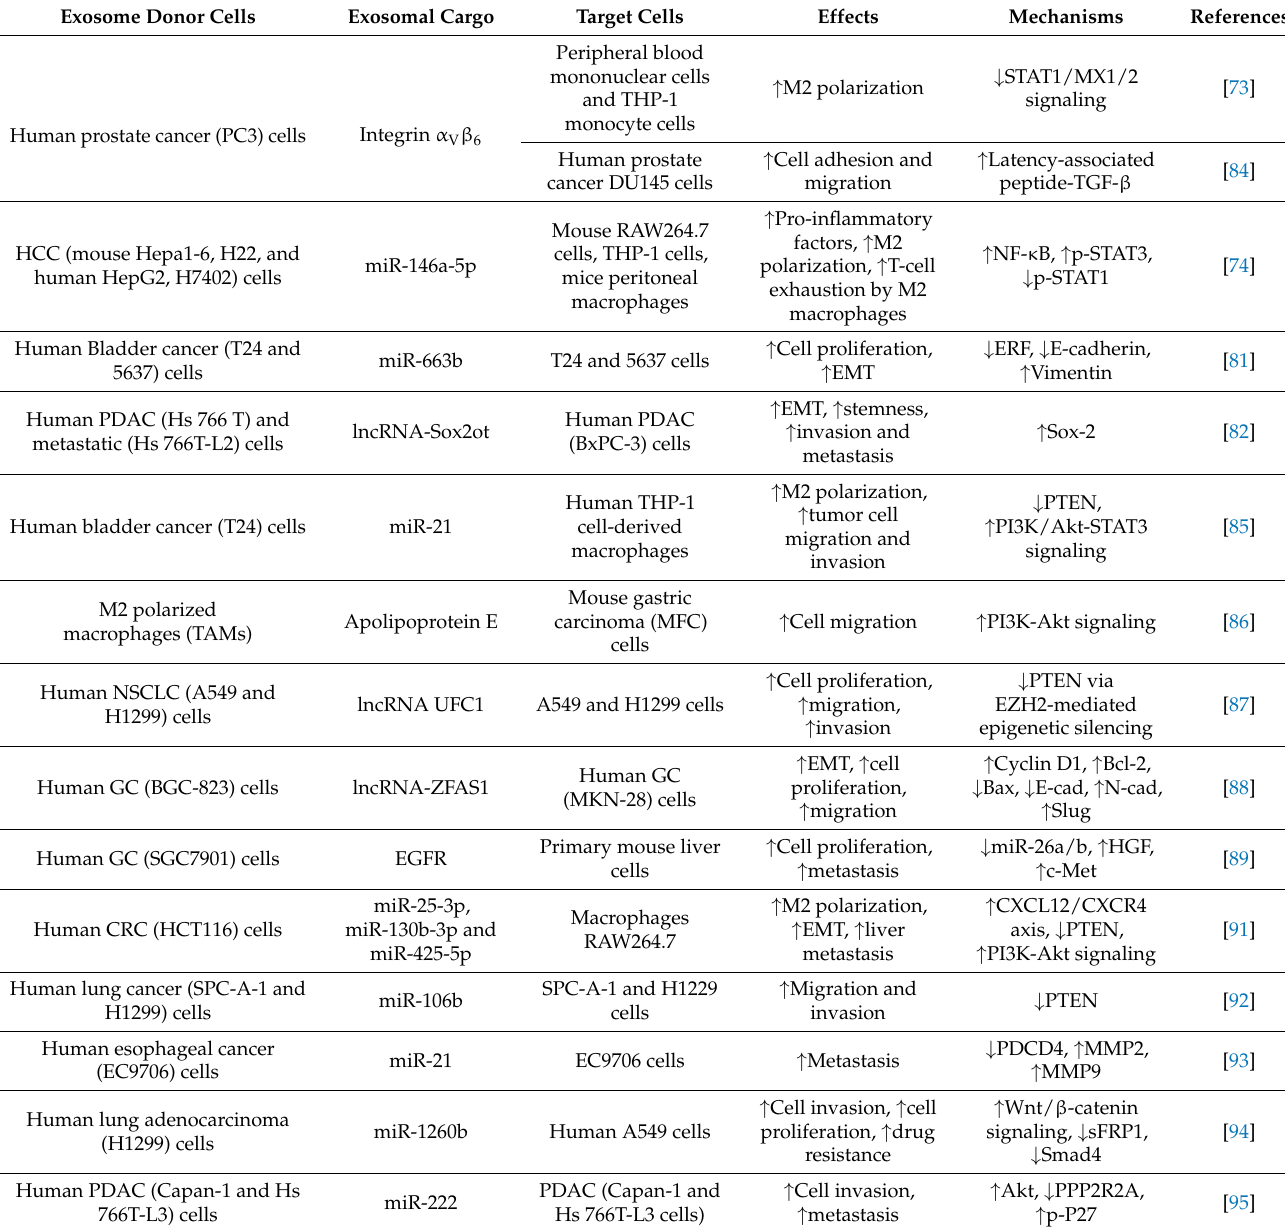
Table 2. Tumor-promoting effects of exosomal cargoes on recipient